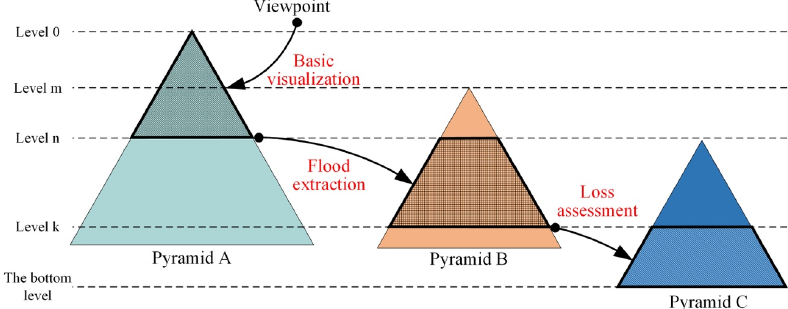
Figure 4. Diverse tile requirements in the 3D visualization of a disaster area.